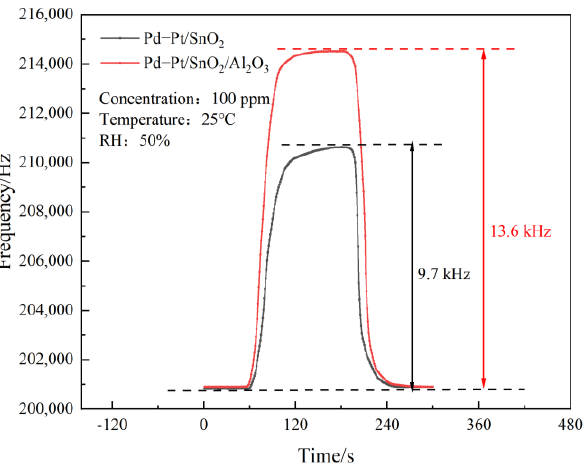
Figure 6. SAW sensor atrophicity test based on Pd–Pt/SnO 2 and Pd–Pt/SnO 2 /Al 2 O 3 thin films.